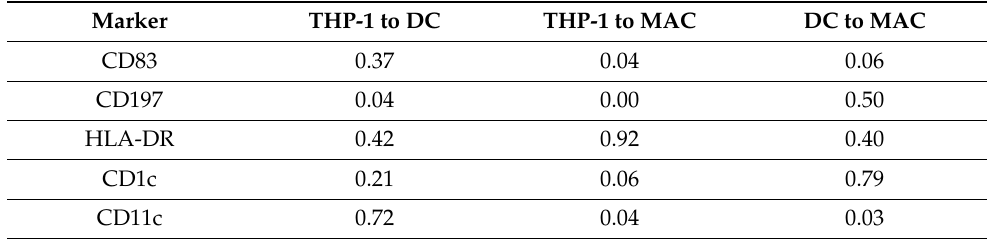
Table A1. Statistical analysis of the flow cytometry results. p values for two sample t -tests using unequal variance were determined using a significance level of